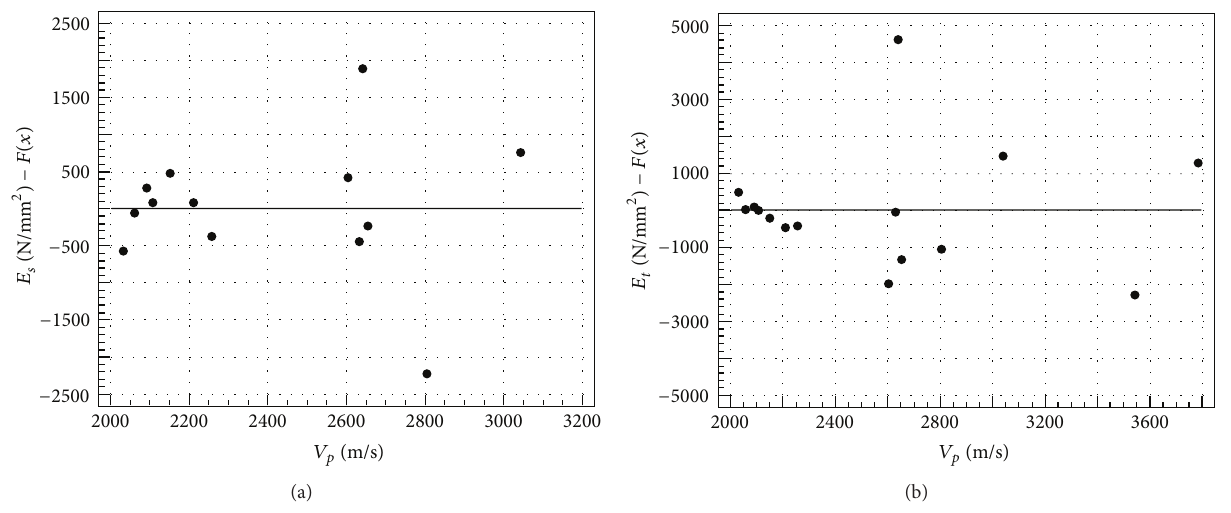
Figure 9: Residuals plot of secant (a) and tangent (b) elastic